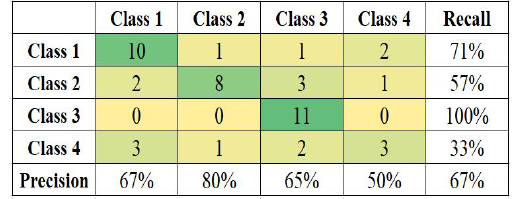
Figure 7. With four damage classes, Nepal scored the second-highest accuracy of 67%. Class 3 has maximum true-positive samples with a recall value of